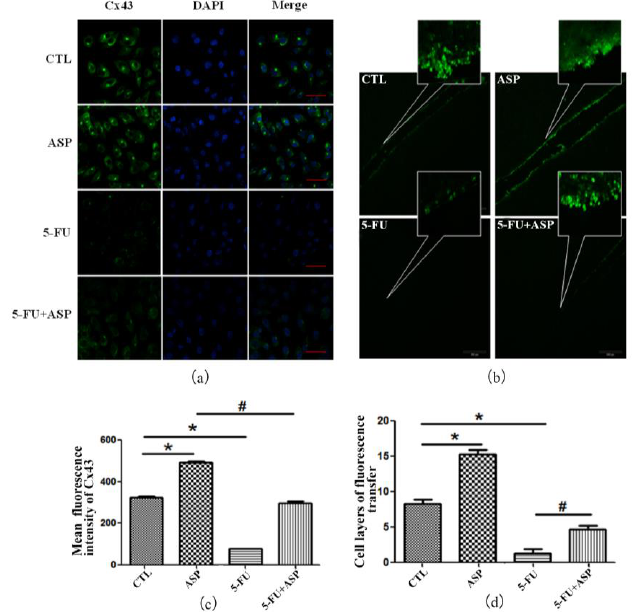
Figure 4. ASP reverses gap junction intercellular communication between bone marrow stromal cells after 5-FU injury. ( a ) Cx43 protein expression in HS-5 cells was detected by confocal laser scanning microscopy and is shown from a merged image of FITC-conjugated Cx43 and 4',6-diamidino-2-phenylindole (DAPI) staining of the nuclei in control ( top ), ASP-treated ( the second panel ), 5-FU-treated ( the third panel ) and 5-FU + ASP-treated ( bottom ) cells (Scale bar = 50 µ m); ( b ) Scrape-loading and dye transfer assay was performed. The Lucifer Yellow transmission layers represent the capacity of intercellular communication; ( c ) Mean fluorescence intensity of Cx43 in HS-5 cells represented as means ± SD; ( d ) The cell layers of fluorescence transfer indicating the capacity of intercellular communication represented as means ± SD. * p < 0.01 vs. control group, # p < 0.01 vs. 5-FU